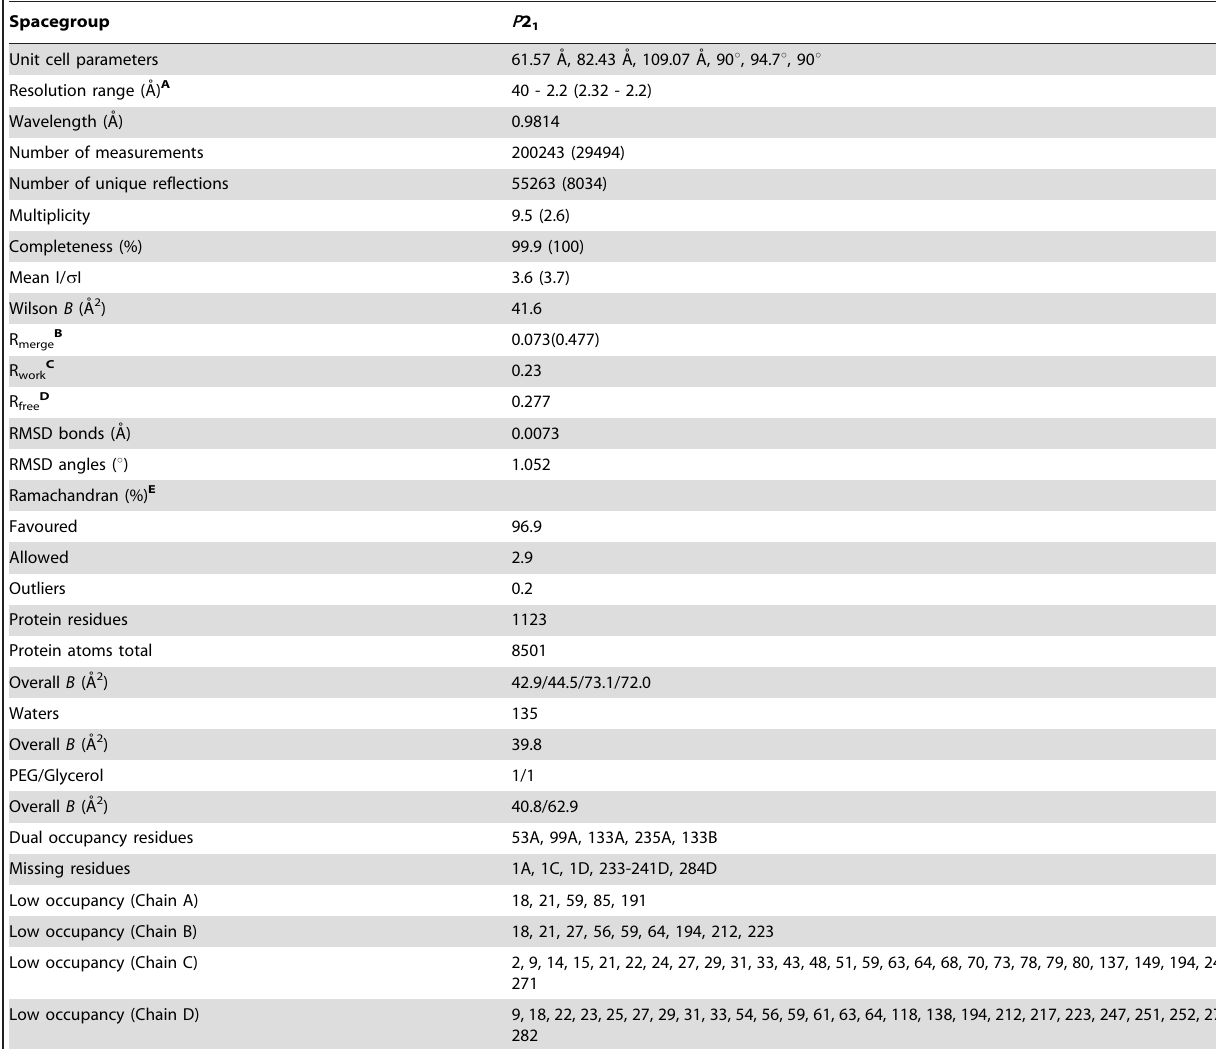
Table 1. Crystallographic